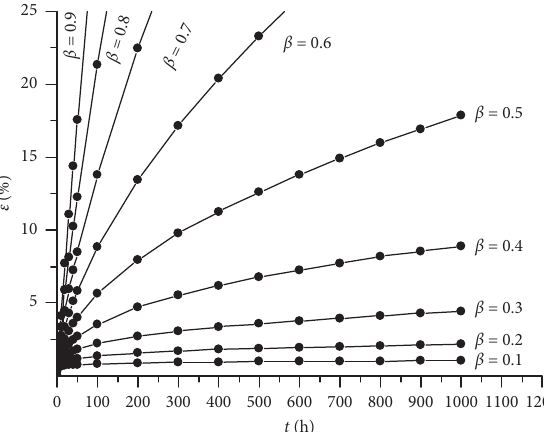
Figure 2: Fractional element creep curves for a range of fractional